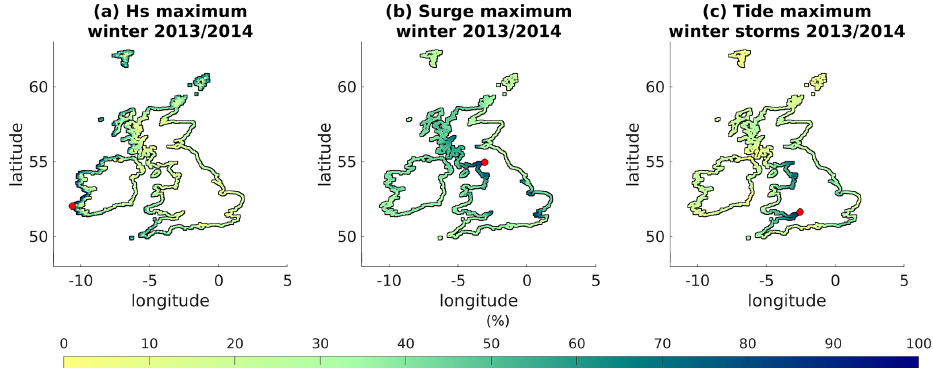
Figure 5. Spatial distribution of the UKC4-simulated maximum H s (a) , surge (b) , and tide (c) that occurred during winter 2013/4. Maxima are given for each coastal point independently of when they occur. Values are expressed as a percentage of the respective overall maximum found over the entire coast in winter 2013/4: these are 14.1m for H s , 2.7m for surges, and 8m for the tide. They are indicated by the red dot. Note that values in some areas seemingly change with distance from the coast (e.g. H s in the west of Ireland); this is because the coastal geomorphology is quite complex in those regions, and the high resolution of the model leads to values changing drastically over short spaces. Only the closest grid cell to the coast is